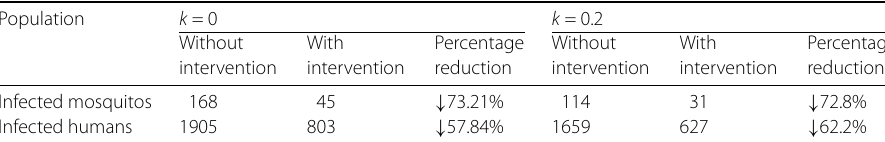
Table 5 The number of infected individuals on day 500 when k = 0 and k =